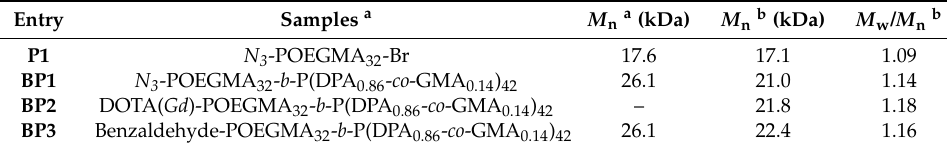
Table 1. Structural parameters of block copolymers used in this